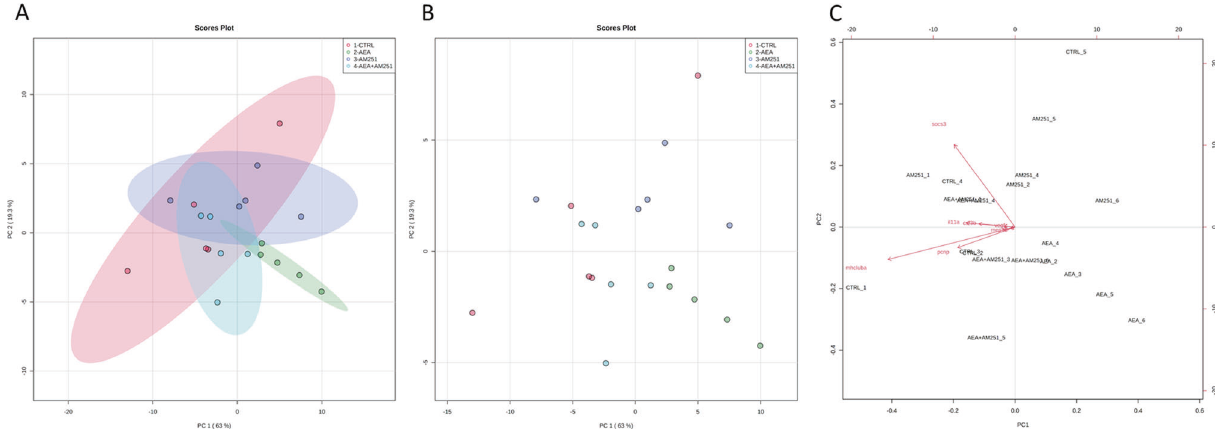
Fig. 6 PCA showing the clear segregation of AEA xenograft and the overlapping of Ctrl, AM251 e AEA + AM251 groups. Score plot of Ctrl (red), AEA (green), AM251 (blue), and AEA + AM251 (light blue) A with 95% con fi dence region or B without 95% con fi dence region. Axes show scores on PC1 (63%) and PC2 (19.3%). C Biplot shows the loading analysis with a red arrow representing the variables. The bottom and left axes show scores on PC1 and PC2, top and right axes show loading